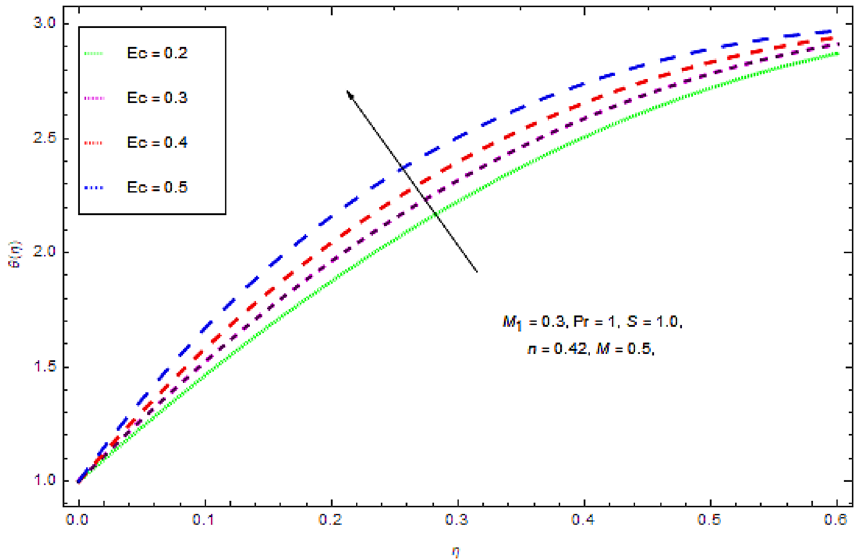
Figure 10. Outcome of Ec on f (η) .